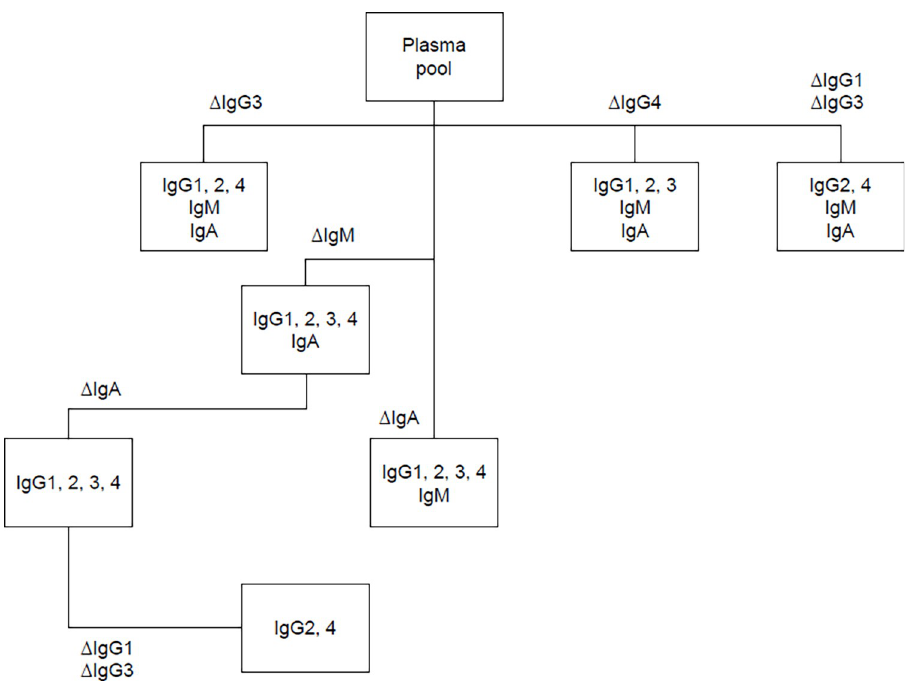
Fig 1. Experimental depletion workflow of convalescent plasma pool. Δ indicates removal of specific Ig class.